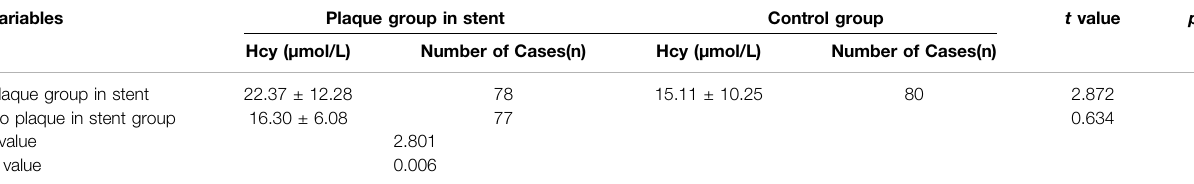
TABLE 5 | Comparison of serum Hcy levels between plaque free group and control group. Variables